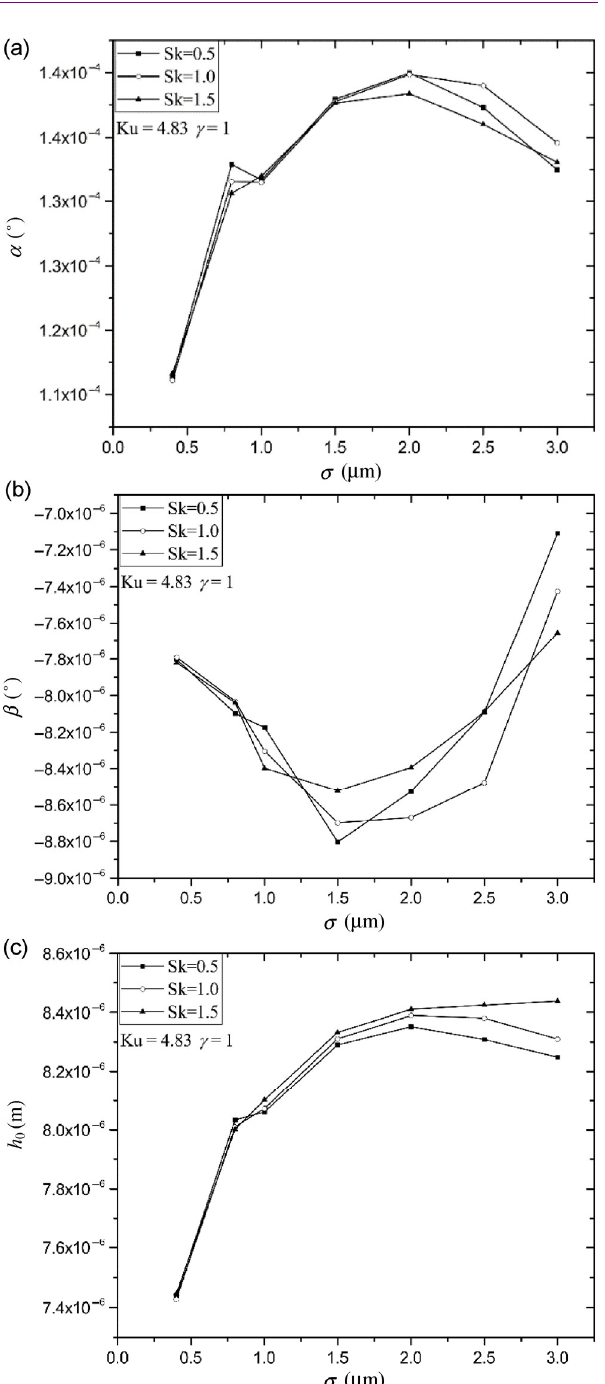
Fig. 5 Tilt angles,  and  and pivot film thickness, h 0 , with various Sk. Ku = 4.83    a   v.s.  b   v.s.  c  h 0 v.s.